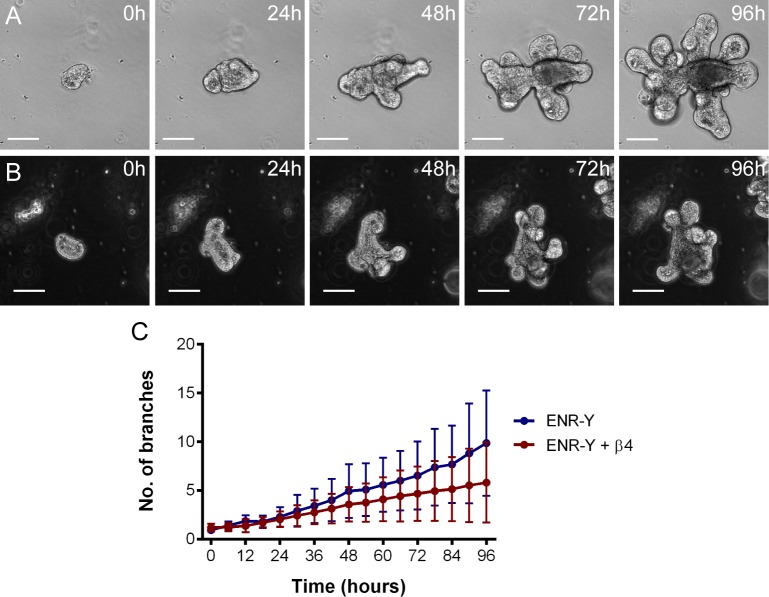
Inhibiting β4 Integrin decreases fission.Organoids grown in control media (ENR-Y; A) or in the presence of a β4 Integrin blocking antibody (B) were recorded by time-lapse imaging. The number of branches were measured every 6 h (C, S9 Data). Branch number increases more slowly in organoids grown in the presence of the β4 Integrin antibody (p < 0.05 from 78 h, t test; n = 21 from three replicates for both conditions), indicating a lower incidence of fission. The different background in panels A and B arises from phase contrast effects at different positions in a well relative to its centre that affect background intensity. Underlying data for panel C can be found in S9 Data.